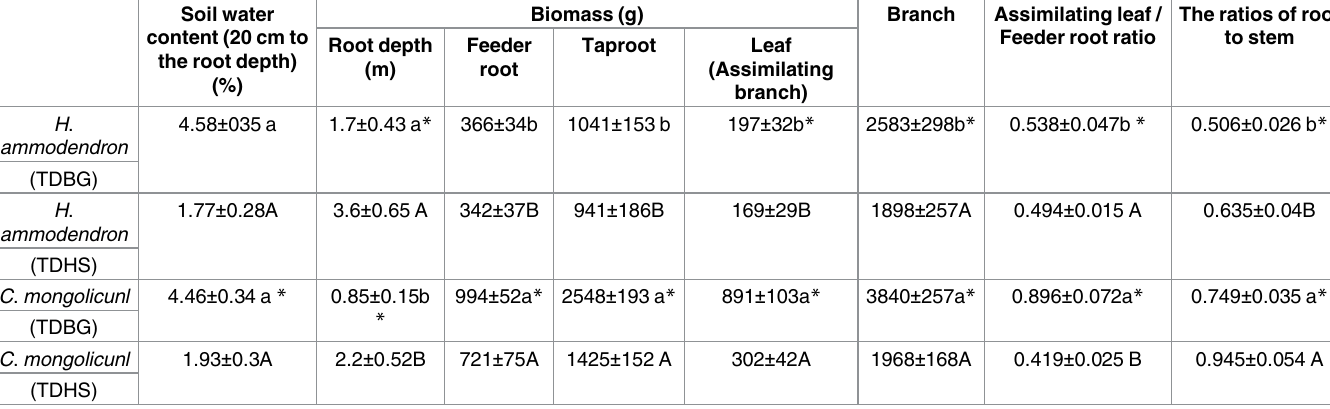
Notes: the * represent significant differences of same species at two position, the different lowercases represent significant differences of two species at TDBG, and the different capital letters represent significant differences of two species at TDHS at P =